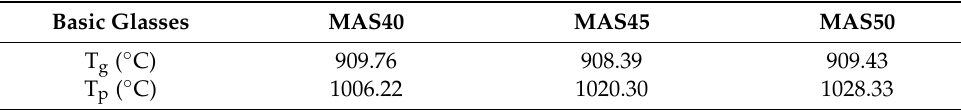
Figure 1. DSC curves of the three parent glasses. Table 3. Thermal parameters of the three parent glasses.